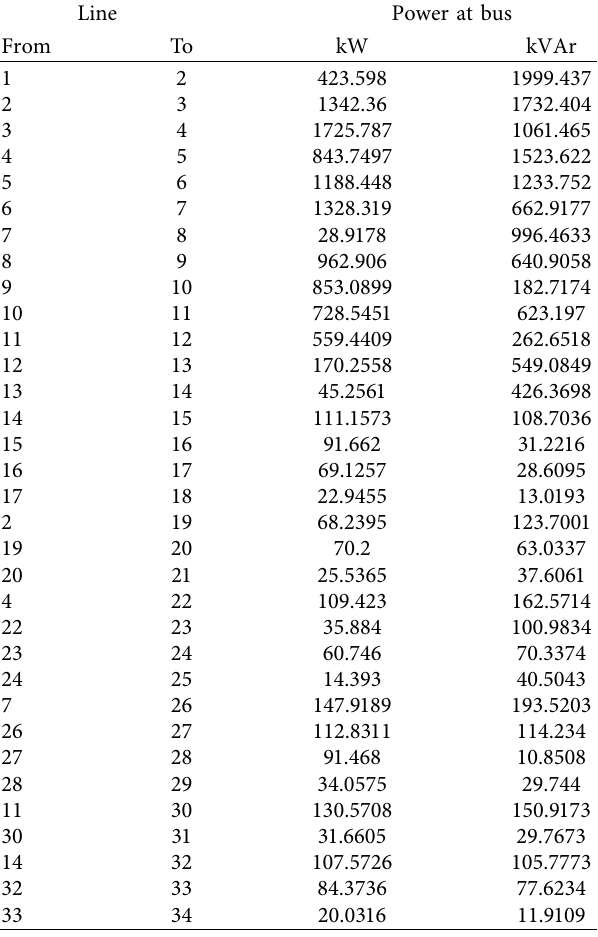
Table 7: Each line real and reactive power in the system run in backward/forward